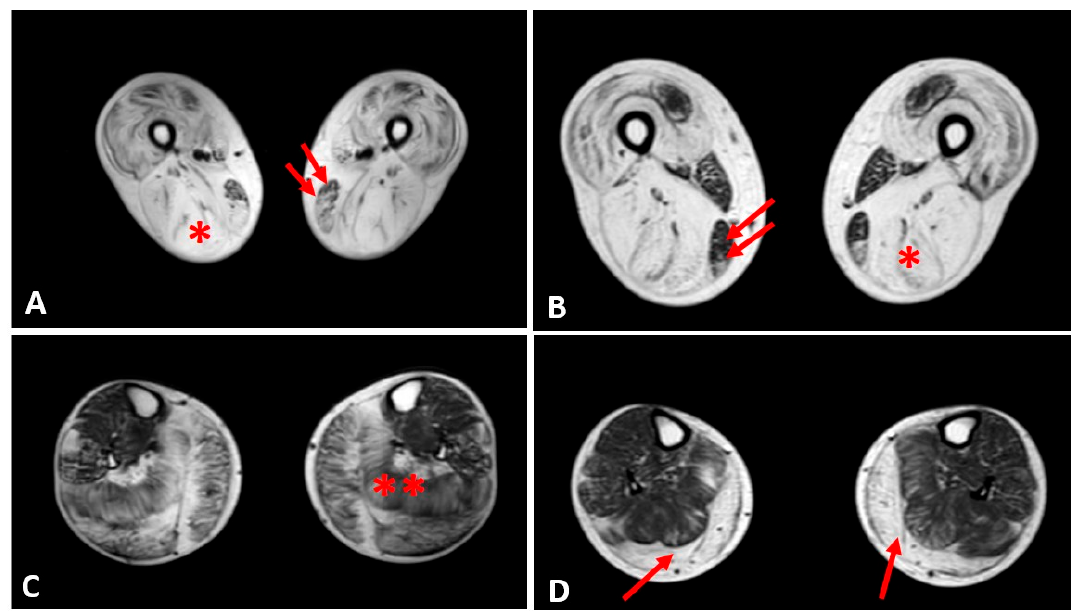
Figure 4. Evaluation of fibrofatty infiltration in lower limbs in two steroid-treated BMD patients. T1-sequences of thigh muscles shows marked atrophy of quadriceps and hamstrings (single asterisk) in both patients sparing of gracilis (double arrows) and sartorius muscles ( A , B ). In leg muscles, gastrocnemius and soleus muscles (double asterisk) presented advanced fatty and connective tissue infiltration in patient 1 ( C ), whereas marked atrophy and moderate fatty infiltration were observed in gastrocnemius muscles (single arrow) of patient 2 ( D ).